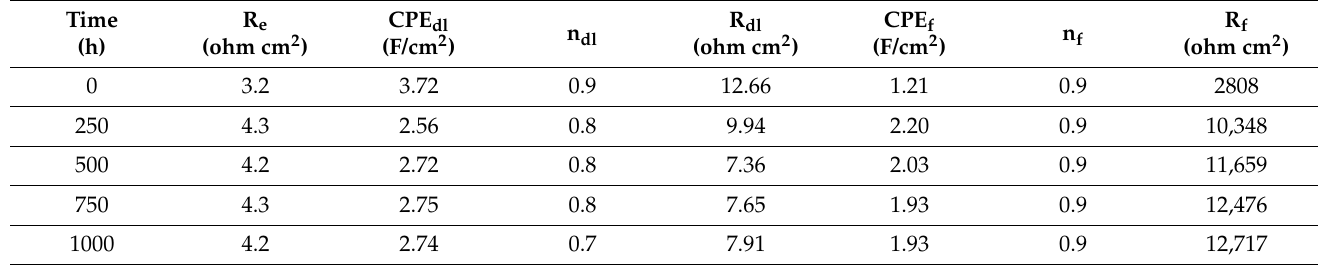
Table 3. Electrochemical parameters obtained from the fitting of the EIS data at 400 ◦ C.